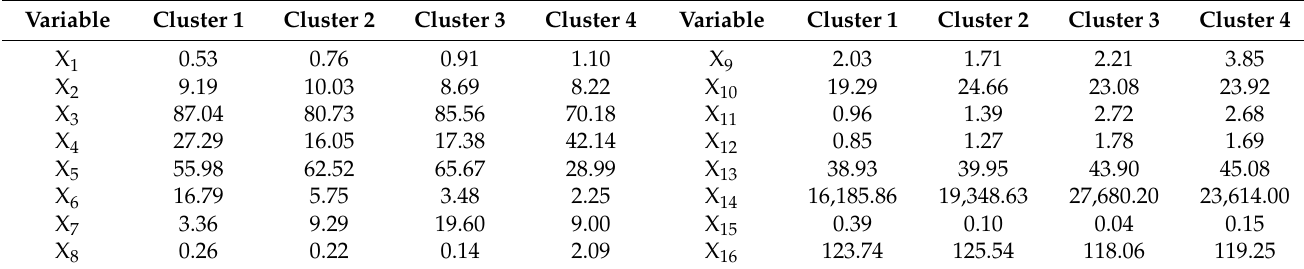
Table 12. Mean values of diagnostic variables in each